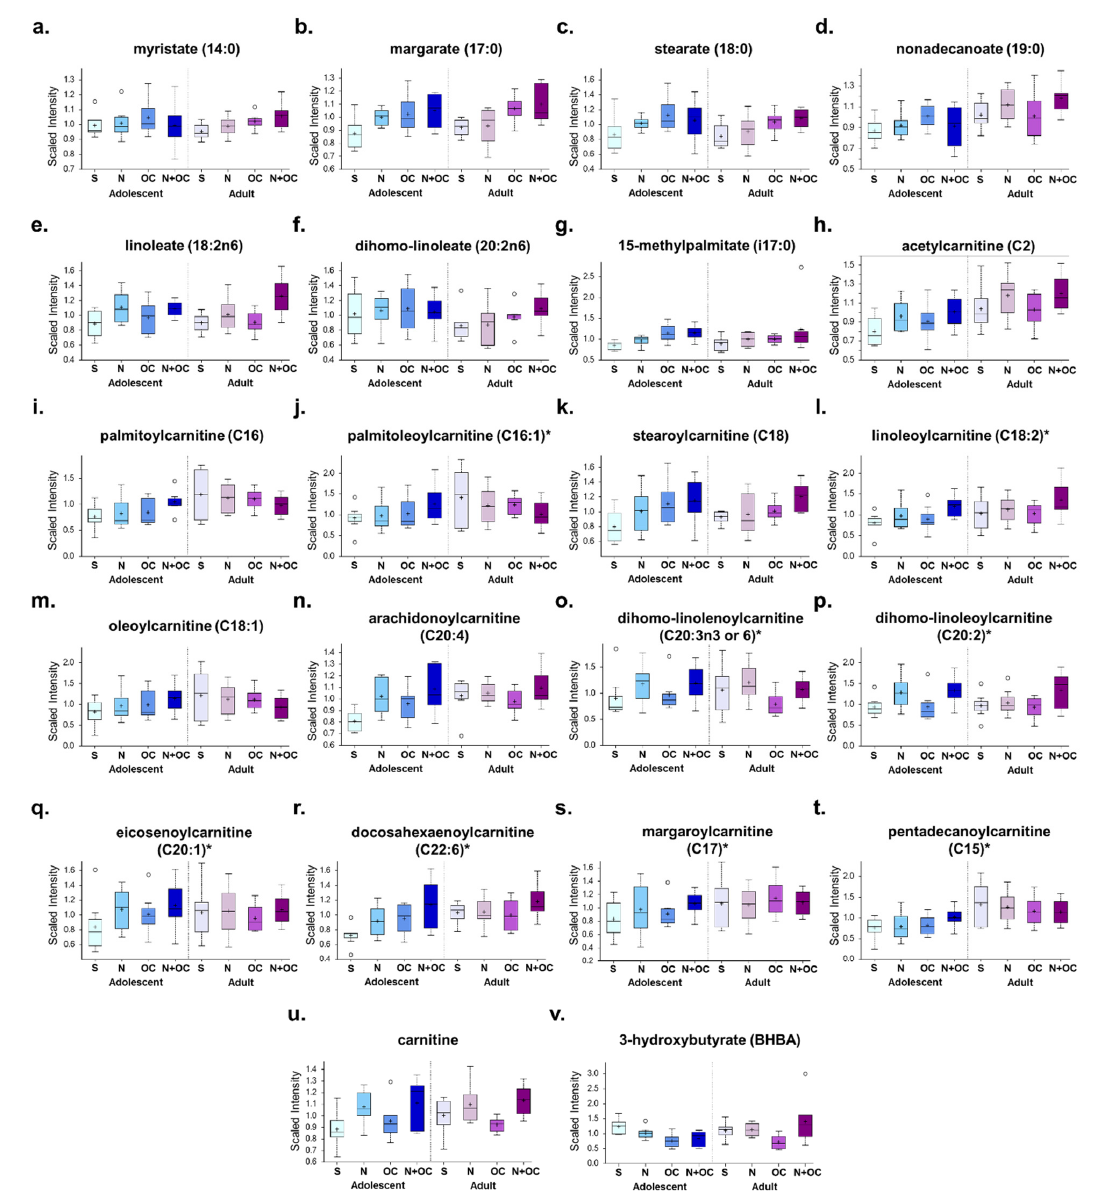
Figure 3. N + OC alters lipid metabolism metabolites, particularly fatty acid oxidation metabolites, in the cortex of adolescent and adult female rats. ( A ) Depicts the fatty acid oxidation pathway that takes place in the mitochondria. The red font indicates a significant increase in the metabolite, and green font indicates a significant decrease. ( B ) Box plots showing that N + OC alters lipid metabo- lism metabolites, particularly fatty acid oxidation metabolites in the cortex of adolescent and adult female rats. ( a – v ) These box plots show significant alterations in myristate (14:0), margarate (17:0), stearate (18:0), nonadecanoate (19:0), linoleate (18:2n6), dihomo-linoleate (20:2n6), 15-methylpalmitate (i17:0), acetylcarnitine (C2), palmitoylcarnitine (C16), palmitoleoylcarnitine (C16:1)*, stearoylcarnitine (C18), linoleoylcarnitine (C18:2)*, oleoylcarnitine (C18:1), arachidonoylcarnitine (C20:4), dihomo- linolenoylcarnitine (C20:3n3 or 6)*, dihomo-linoleoylcarnitine (C20:2)*, eicosenoylcarnitine (C20:1)*, docosahexaenoylcarnitine (C22:6)*, margaroylcarnitine (C17)*, pentadecanoylcarnitine (C15)*, carni- tine, and BHBA fold change in the cortex of saline-, N-, OC-, and N + OC-exposed rats. “Biochemical name*” indicates a compound that has not been confirmed based on a standard, but Metabolon is confident in its